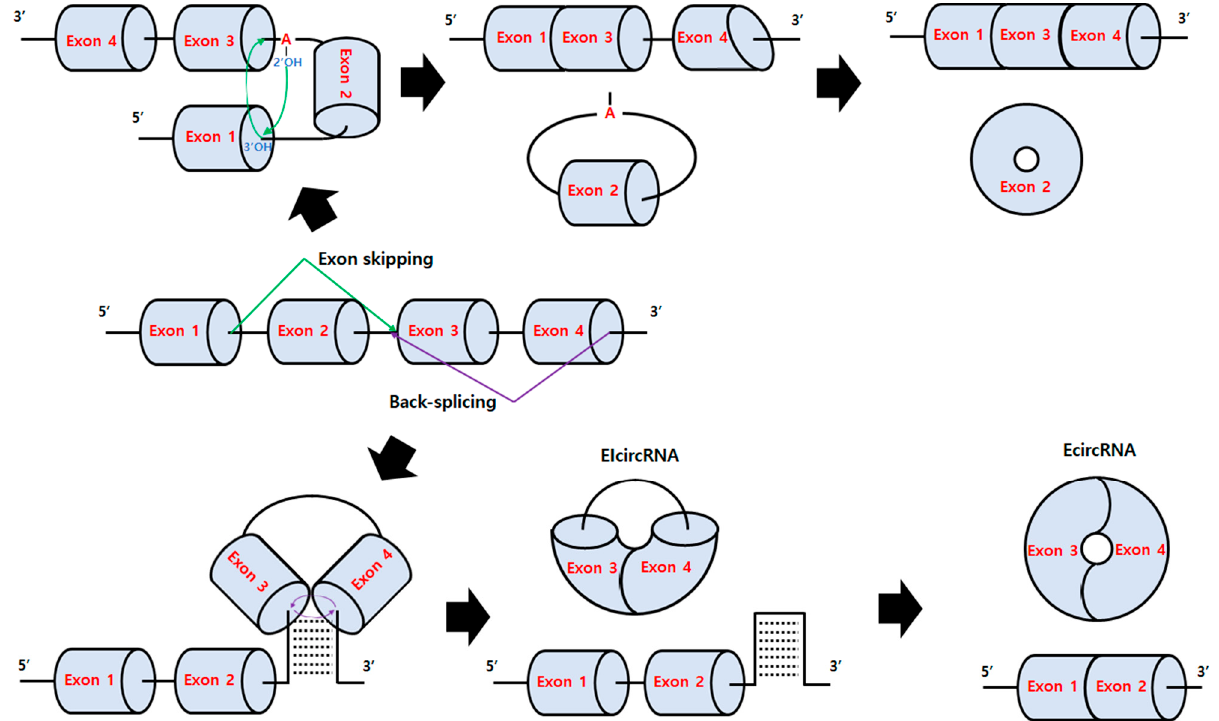
Figure 1. Exon skipping and back ‐ splicing mechanisms [7,12]. For exon skipping (green line), a lariat is created by skipping an exon during the normal splicing mechanism ( a ttack of a 2 ′‐ OH group of defined adenosine within the intron onto the 5 ′‐ splice site at the 5 ′ exon (Exon 1) to generate a free 3 ′‐ OH, then the nucleophilic attack of the generated 3 ′‐ OH onto the 3 ′‐ splice). Then, lariat splicing occurs, resulting in Ecircular RNA formation. For back ‐ splicing (purple line), intronic complementary sequences such as Alu elements (abundant transposable elements in primate genome) pair and form an RNA duplex (RNA ‐ binding protein ‐ driven pairing is also possible) that closely juxtapose the splice sites for nucleophilic attack of the 5 ′‐ branch point onto a 3 ′‐ splice donor and the subsequent attack of the 3 ′‐ splice donor onto a 5 ′‐ splice acceptor, resulting in the formation of exon ‐ intron circRNA (EIcircRNA) with intron retention or exonic circRNA (EcircRNA) after internal splicing.